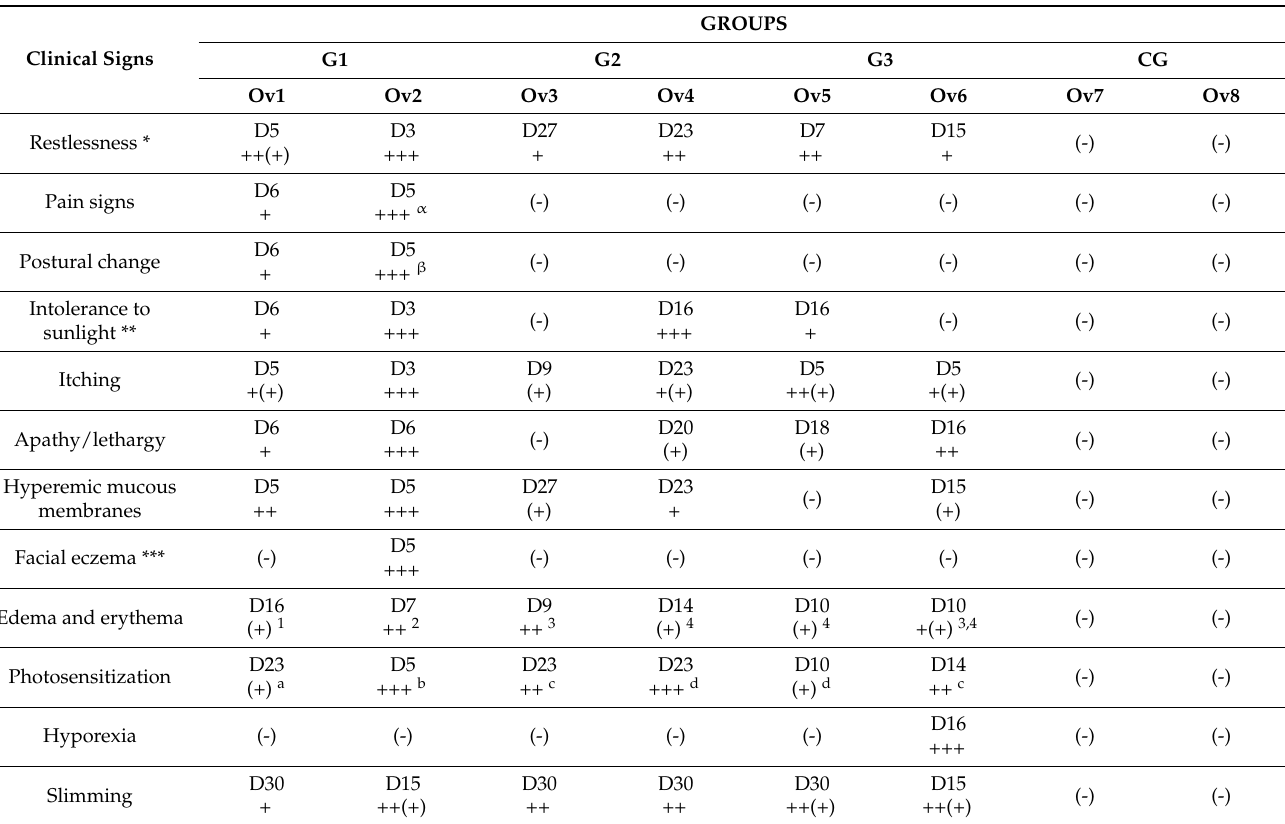
Table 2. Experimental poisoning by Chamaecrista serpens in sheep. Main clinical signs, evolution and intensity of